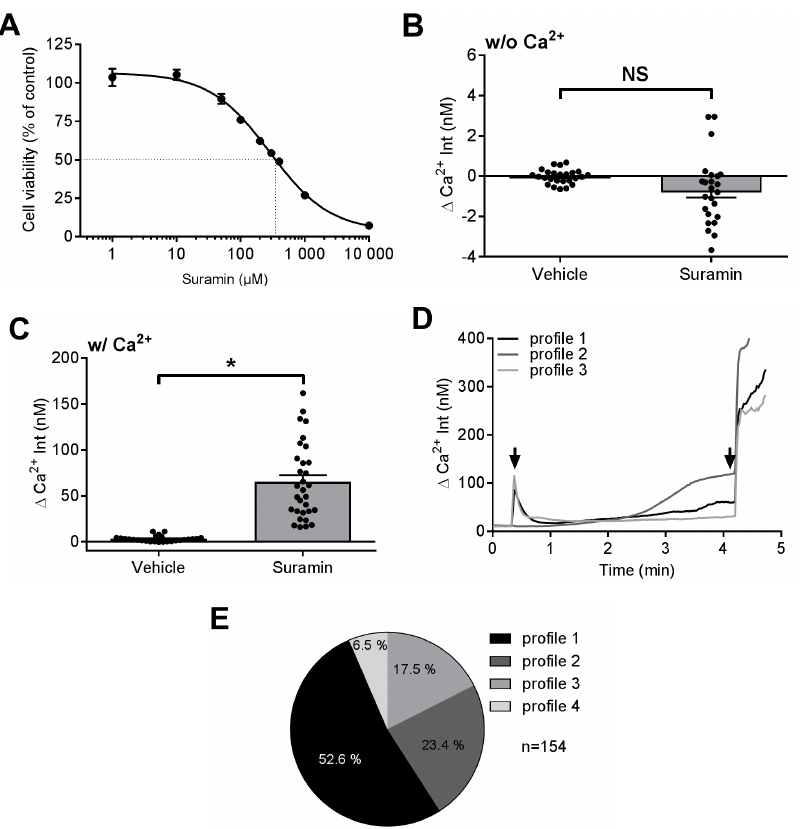
Figure 2. Effects of suramin on cell viability and intracellular calcium in dorsal root ganglia neurons. ( A ) Increasing suramin concentrations between 10 and 10,000 µ M led to a dose-dependent decrease of cell viability with a calculated IC 50 of 283 µ M (non-linear regression analysis); ( B ) DRGN